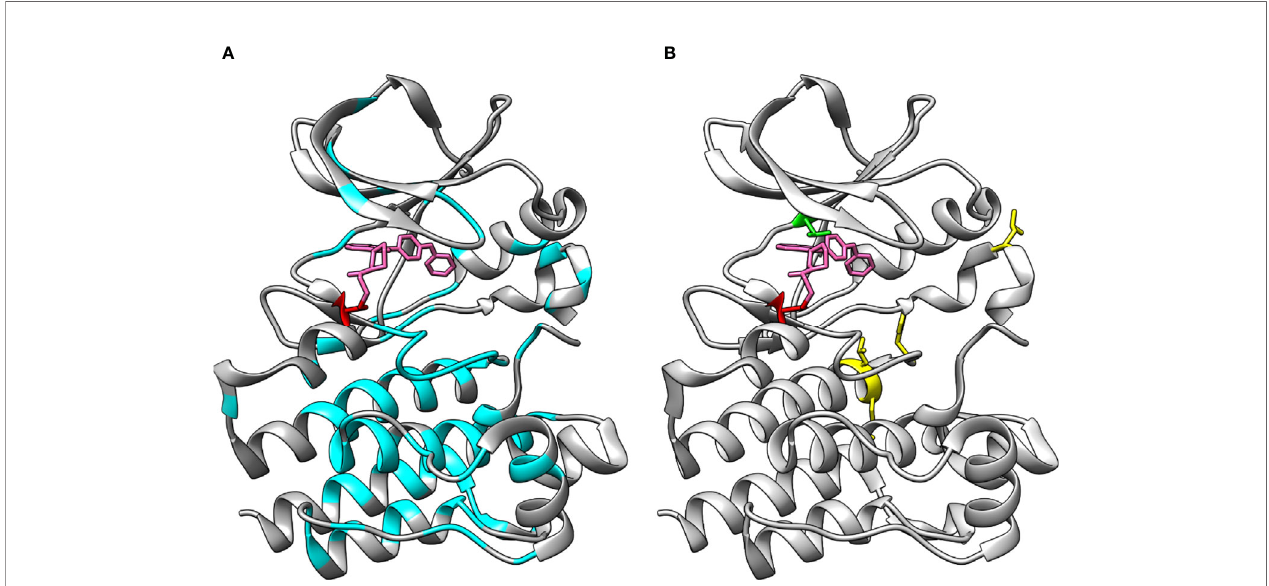
FIGURE 6 | Loss- and gain-of-function variations in BTK kinase domain. (A) XLA-causing variants (cyan) are distributed all along the kinase domain. (B) Sites of ibrutinib resistance conferring amino acids C481 (red) and T474 (green) along with gain-of-function variants at positions 512, 513, 517 and 547 (yellow), note that variant at 474 alone and together with other variants lead to gain-of-function activities. The structures are for ibrutinib (pink) complex with BTK